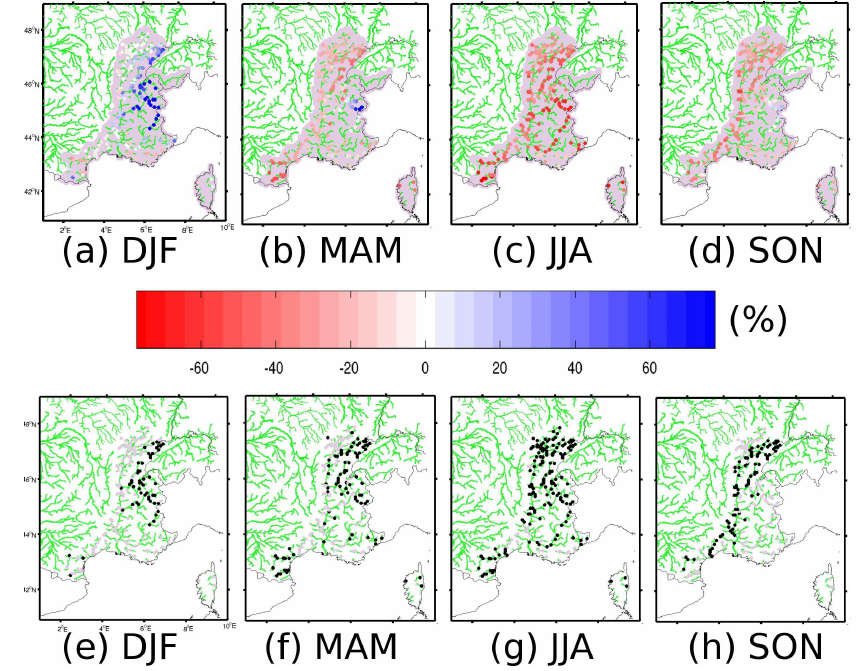
Figure 9: First row: anomalies of average seasonal discharge obtained with ISBA-A-gs. Second row: significance of the anomalies: black means that the changes are statistically significant and light grey means they are not. The anomalies are calculated by comparing two periods: 2069–2099 vs. 1970–2000.